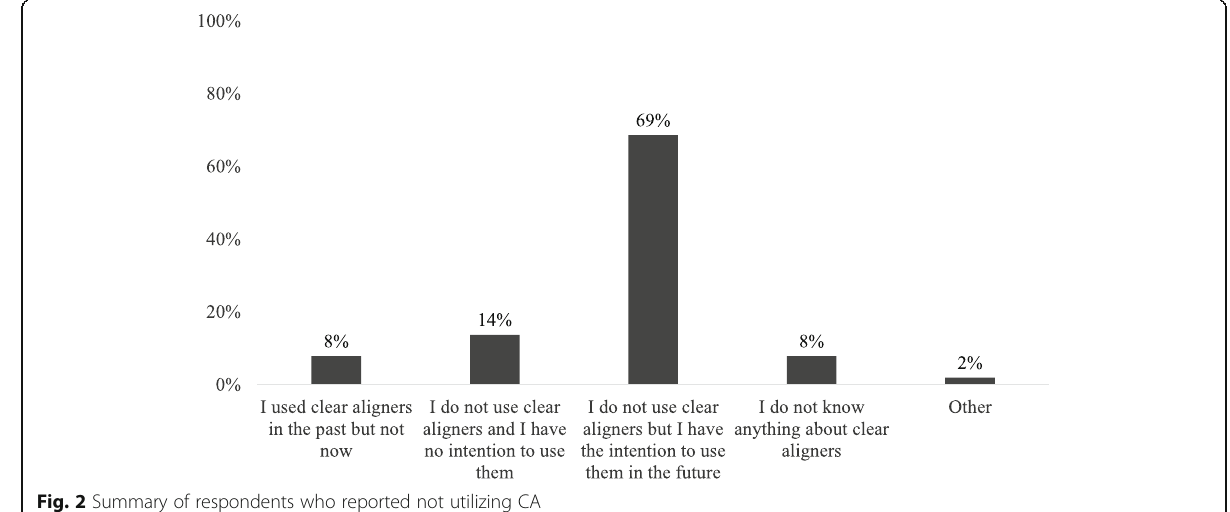
Fig. 2 Summary of respondents who reported not utilizing CA